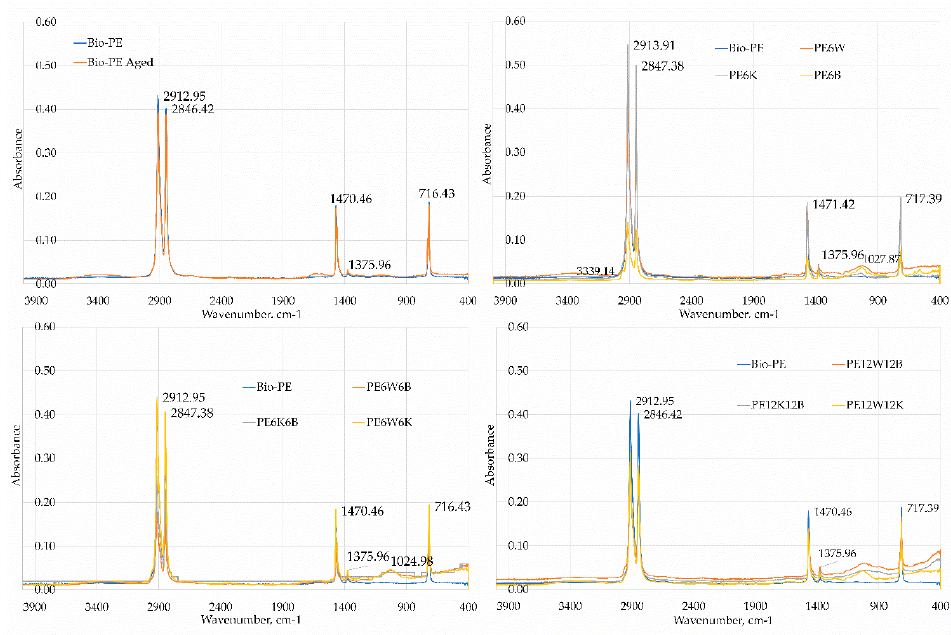
Figure 7. Fourier transform infrared (FTIR) spectra of tested materials.